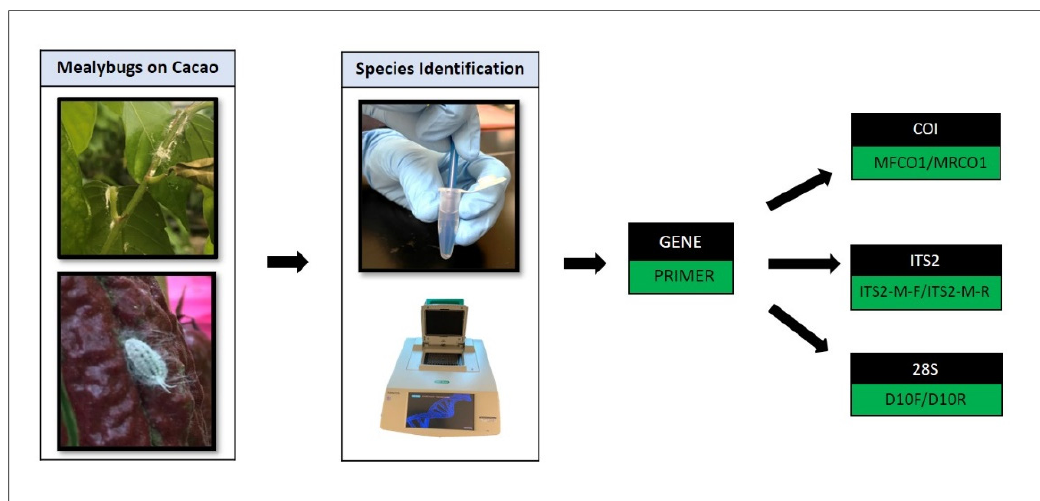
Figure 2. Mealybugs feeding on virus-infected trees of Theobroma cacao were identified using COI, ITS2, and 28S markers amplified and sequenced using MFCO1/MRCO1, ITS2-M-F/ITS2-M-R, and D10F/D10R primers. Table 1. Genes, primer sequences, and amplicon sizes for the markers targeted in this study.